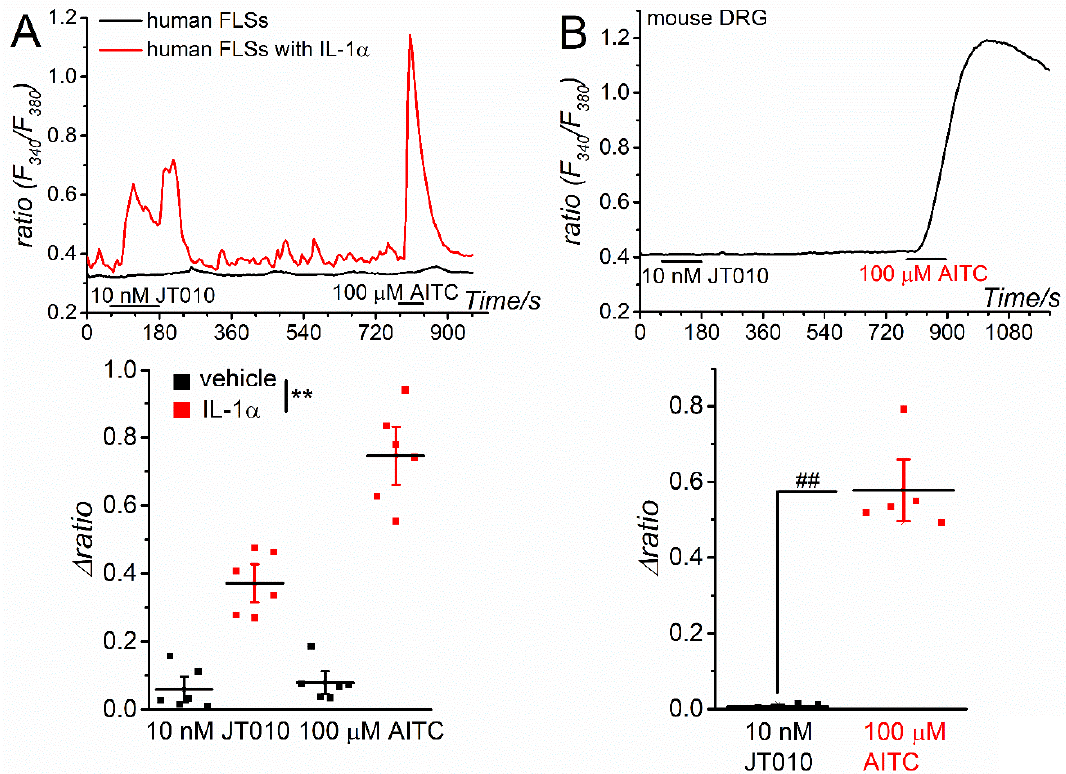
Figure 3. Effects of JT010 on endogenous TRPA1 in human and mouse cells. ( A ) JT010 at 10 nM and AITC at 100 µ M were applied to human FLSs with or without inflammation. FLSs were treated with 10 U IL-1 α or vehicle for 24 h and then exposed to JT010 and AITC, and Ca 2+ response was monitored (( A ), each representative cell). The peak JT010- and AITC-induced Ca 2+ response ( ∆ ratio) in FLSs with or without IL-1 α (six independent experiments each) are summarized in the lower panel. Two-way ANOVA: ** p < 0.0001, F = 167 (pretreatments); ** p < 0.0001, F = 27.0 (drugs); ** p = 0.00015, F = 21.7 (interaction) ( B ) JT010 at 10 nM and AITC at 100 µ M were applied to mouse DRGs, and Ca 2+ response was monitored (( B ), a representative cell). The peak JT010- and AITC-induced Ca 2+ response ( ∆ ratio) in DRGs are summarized (lower panel, five independent experiments).